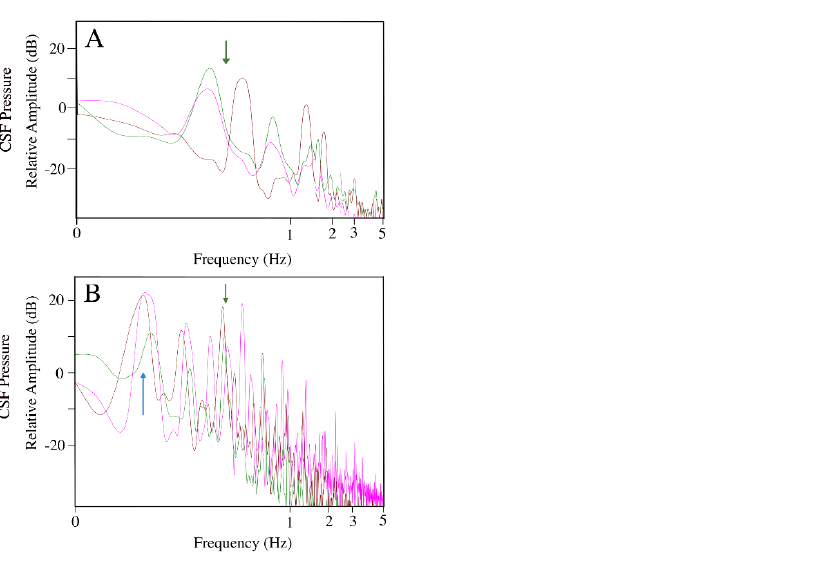
Figure 8. Consistency of the cardiac-related CSF pulsations. Power spectral analyses of three different specimens of Alligator mississippiensi (individuals’ traces are color coded); data were taken post- recovery during the locomotor trials ( A ) and immediately pre-surgery ( B ). The pre-surgery records included a ventilatory component (blue arrow). While there was some variation in heart rate, all of the traces had a clear cardiac-related frequency (green arrow) which was distinct from all of the other frequencies recorded during the experiment.